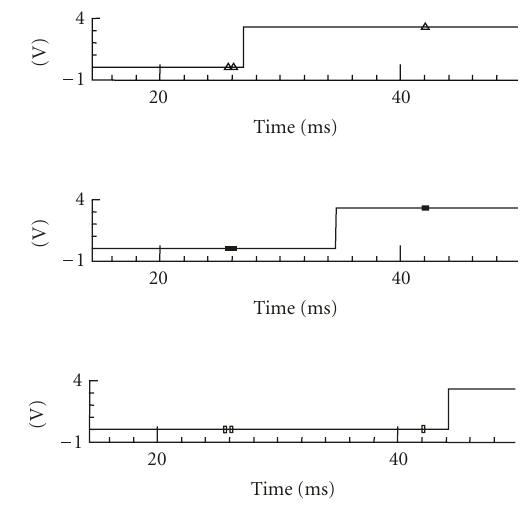
Figure 11: Response time of pixel cell from input current (i.e., brightness) change to feature output (stimuli change at 20ms).